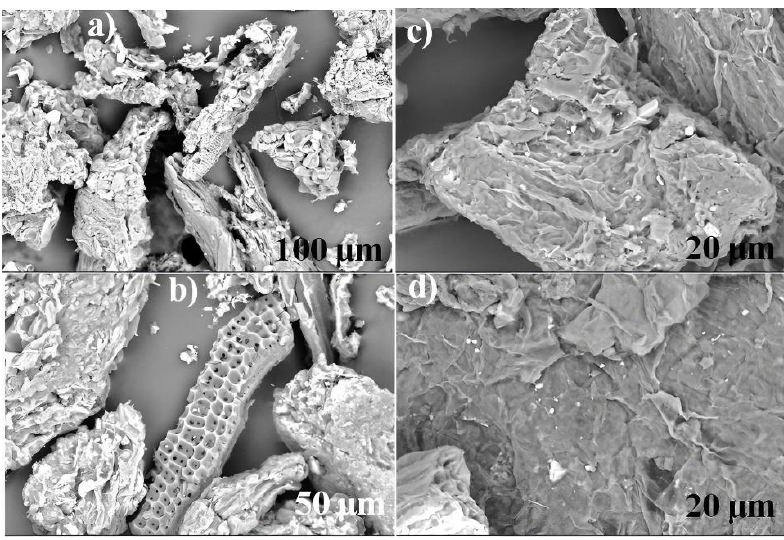
Figure 8. SEM micrographs of NWL after adsorption: for PR ( a , b ); for GV ( c , d ). Table 11. Elemental analysis of WL treated with water and NaOH.